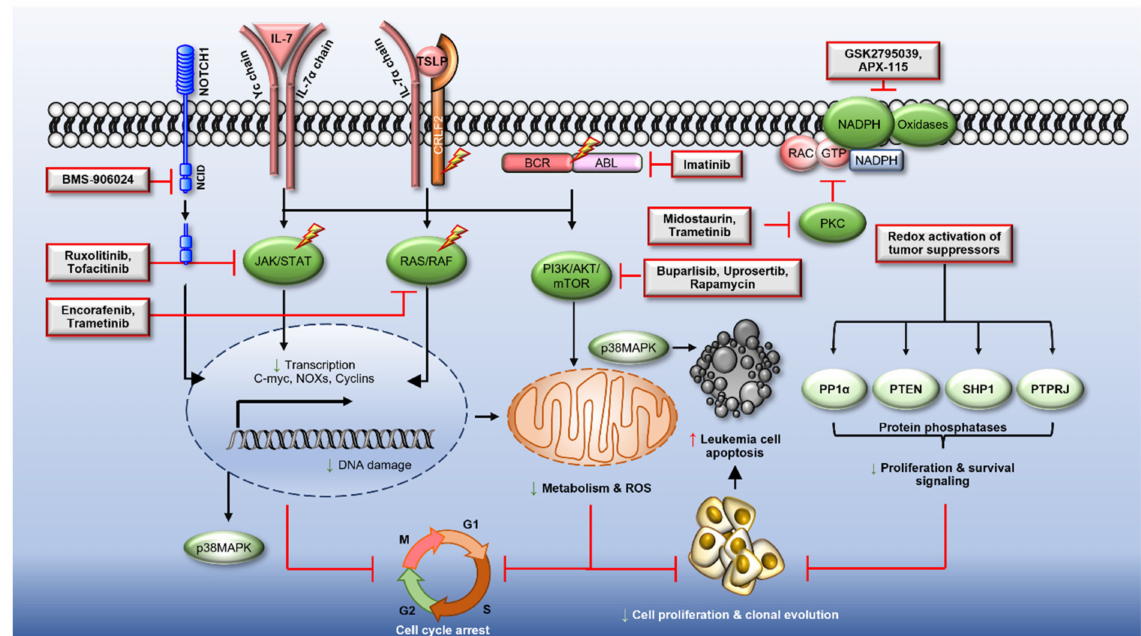
Figure 3. Therapeutic strategies targeting reactive oxygen species production for the treatment of acute lymphoblastic leukaemia. Therapies targeting oncogenic kinases in acute lymphoblastic leukaemia (ALL) reduce ROS production. NOX inhibitors (NOXi) used in combination with targeted therapies synergise with ALL tyrosine kinase inhibitors (TKIs) or kinase inhibitors (KIs) and are emerging as a novel therapeutic strategy. Red shapes = proteins with increased activity or expression; dark green shapes = decreased activity or expression; lightning bolt = proteins harbouring mutations/translocations; orange = oxidised proteins; light green = reduced